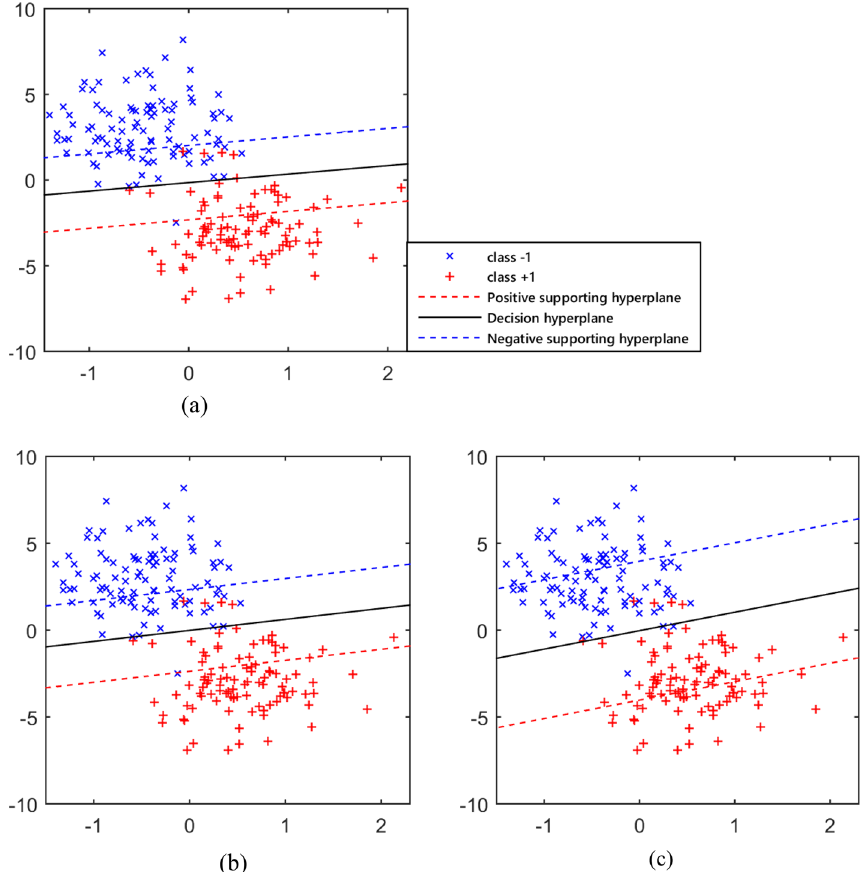
Fig. 1 Illustrations of a SVM, b FPin-SVM with τ = 0.1, and c FPin-SVM with τ = 1 on a 2-D synthetic